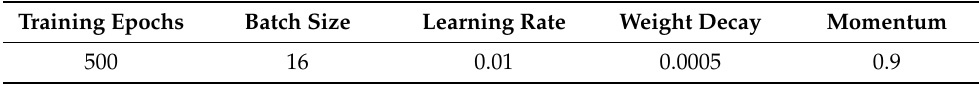
Table 1. Hyperparameter settings of network